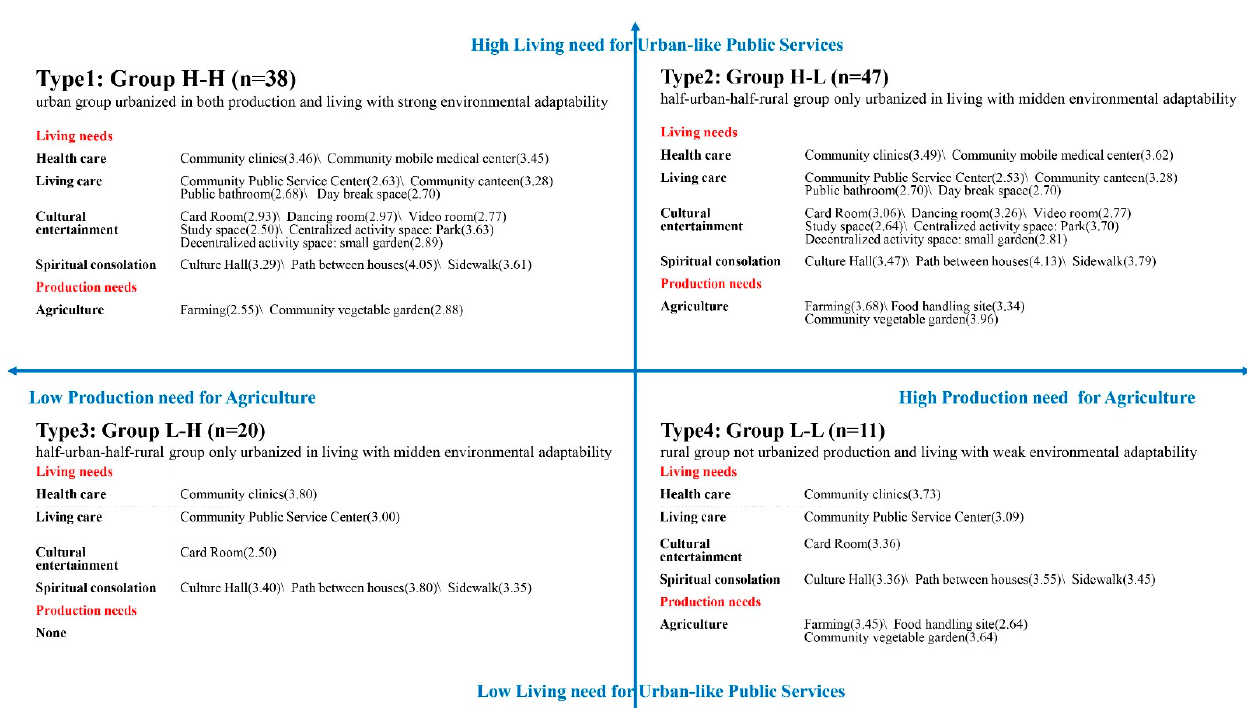
Figure 4. Decomposition model of urbanization features based on need (Source: Author).